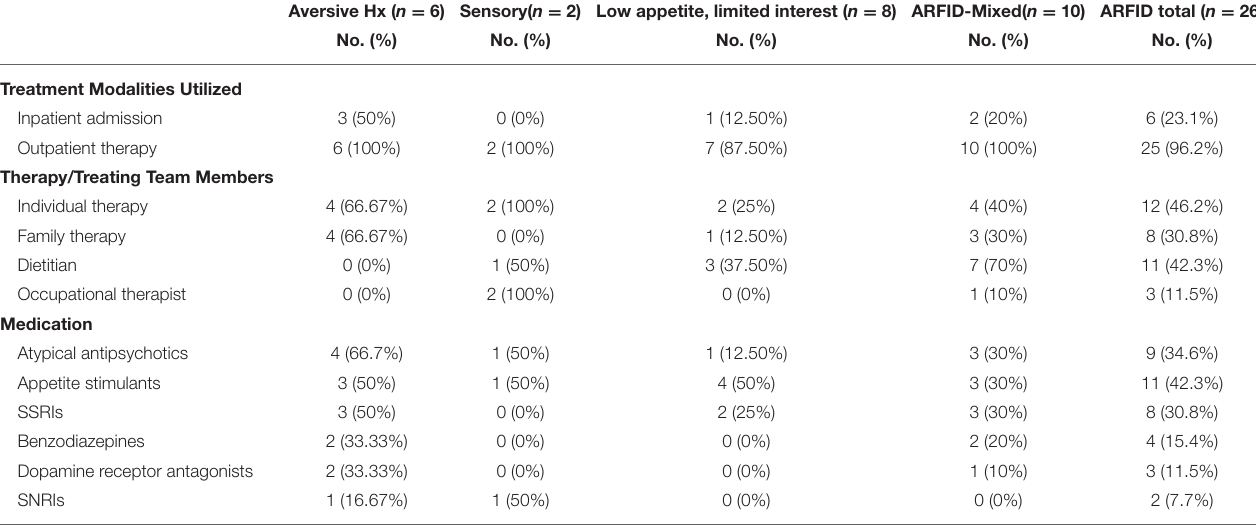
TABLE 3 | Treatment modalities used for the management of pediatric ARFID patients ( n = 26) admitted to a specialized pilot clinic.